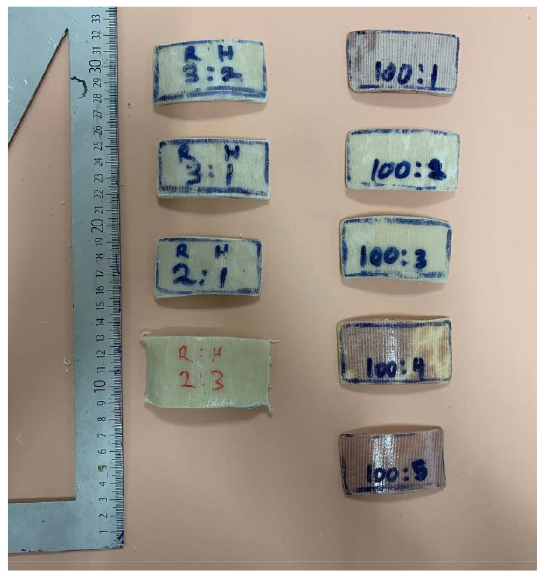
Figure 1. Samples cutouts.